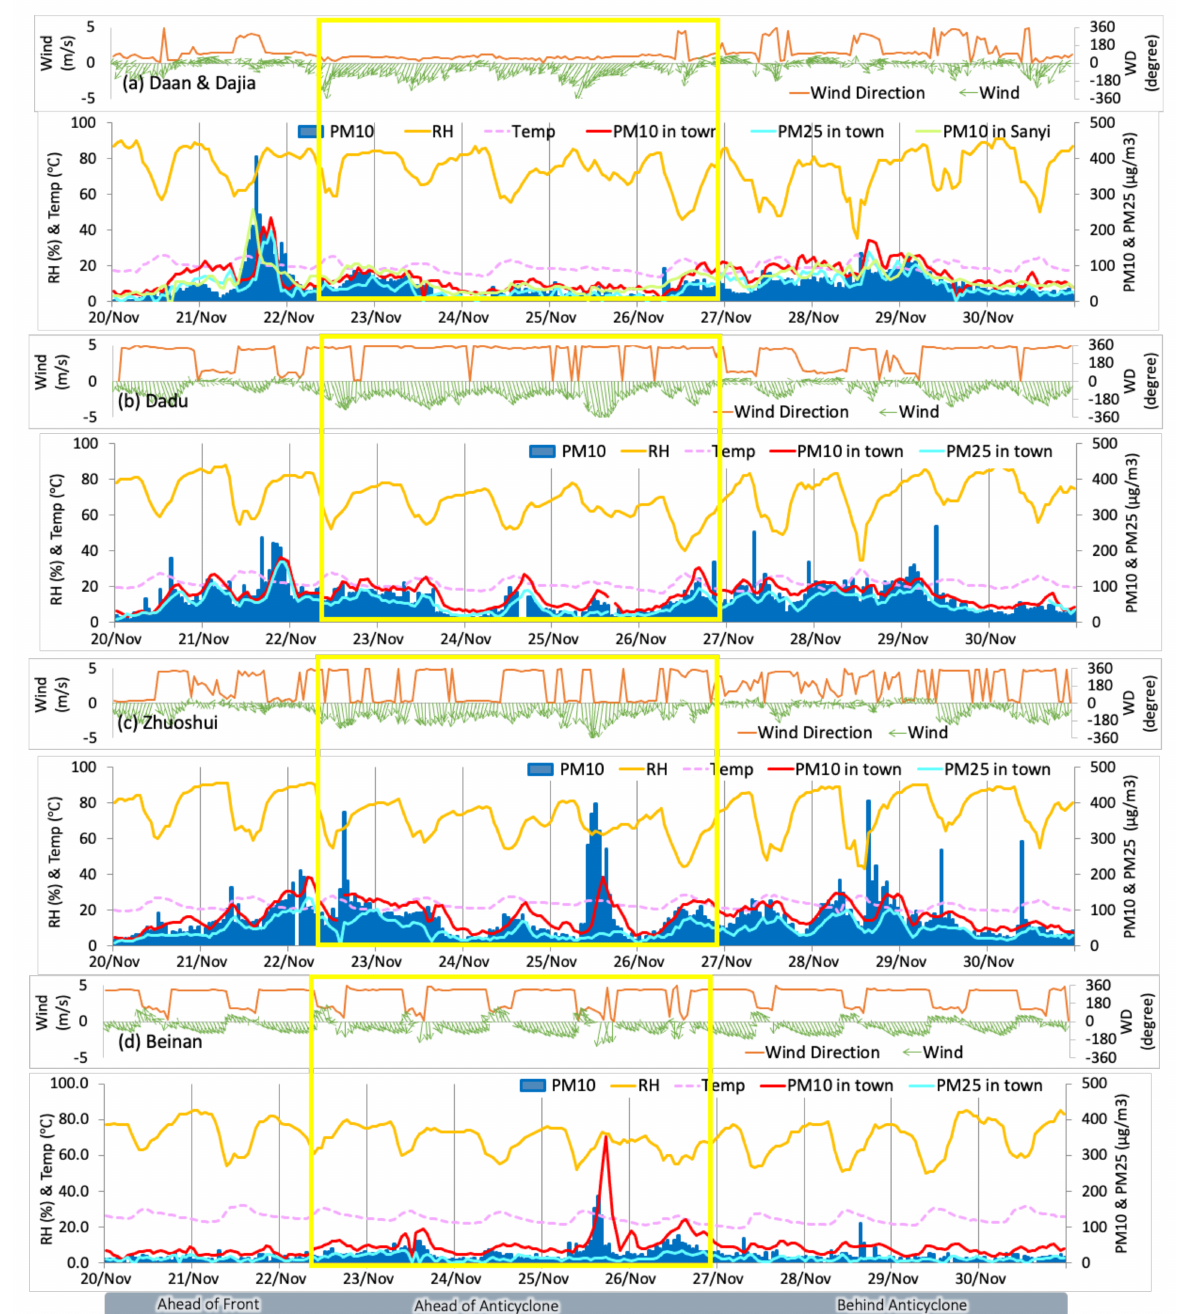
Figure 6. Same as in Figure 5, except for the non-typhoon type that occurred from 20 November to 30 November 2010. The ahead of anticyclone stage is marked with a yellow